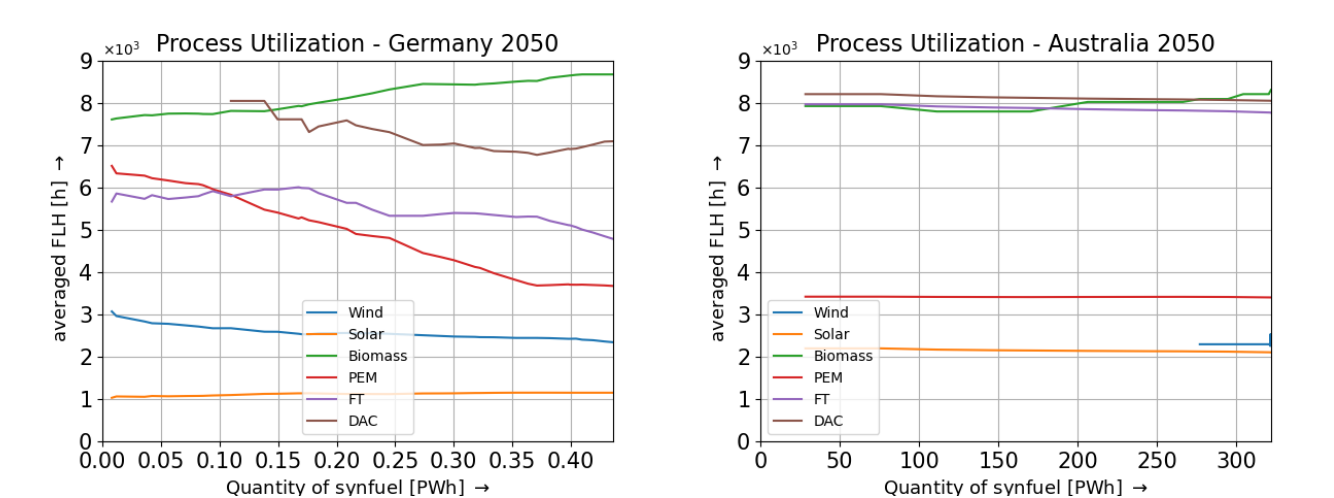
Figure 7. Utilisation of each technology for Germany and Australia in